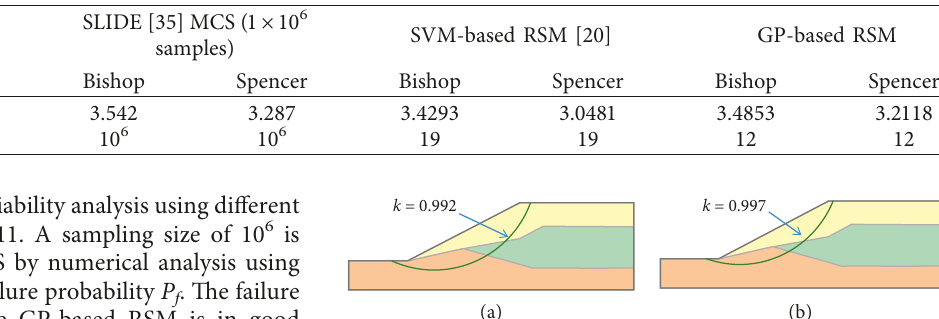
Table 11: Results comparison of Example 3.